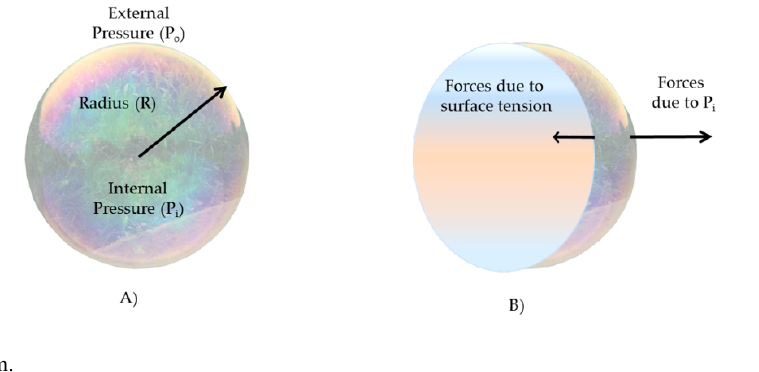
Fig. 2. Soap bubble in